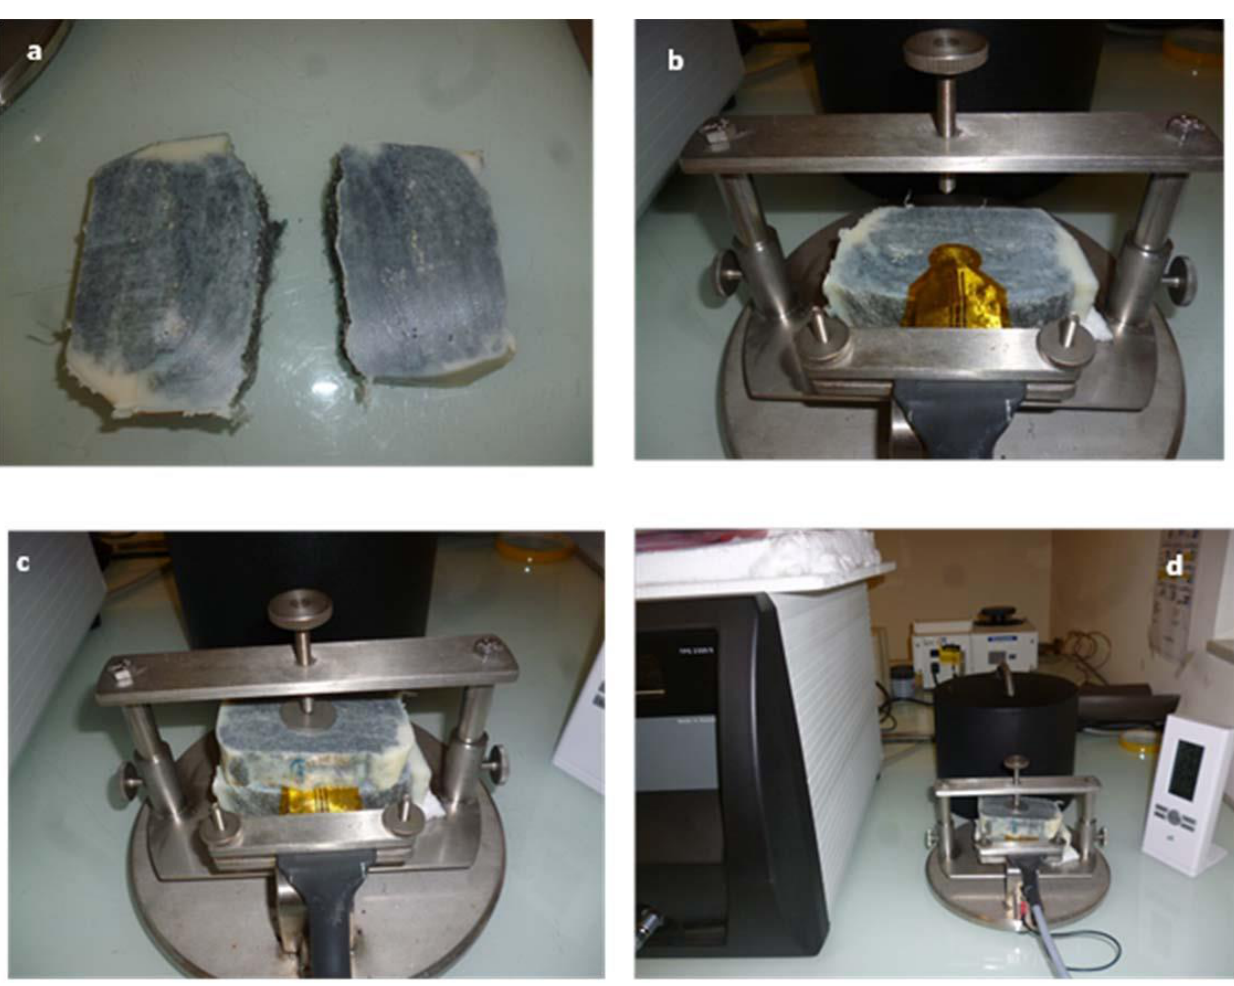
Figure 8. Hot disc method. ( a ) Samples to be tested, ( b ) Kapton sensor to the used, ( c ) Kapton sensor between to test samples, and ( d ) full equipment.